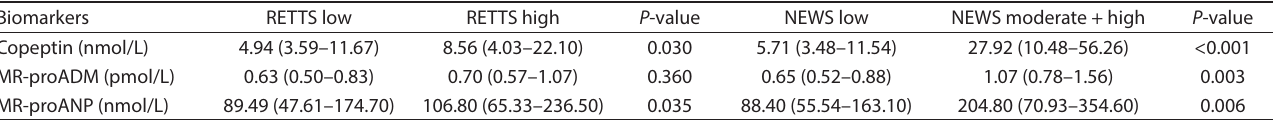
Table 3. Median (IQR) levels of copeptin, MR-proADM, and MR-proANP across the categories of NEWS and RETTS. Biomarkers